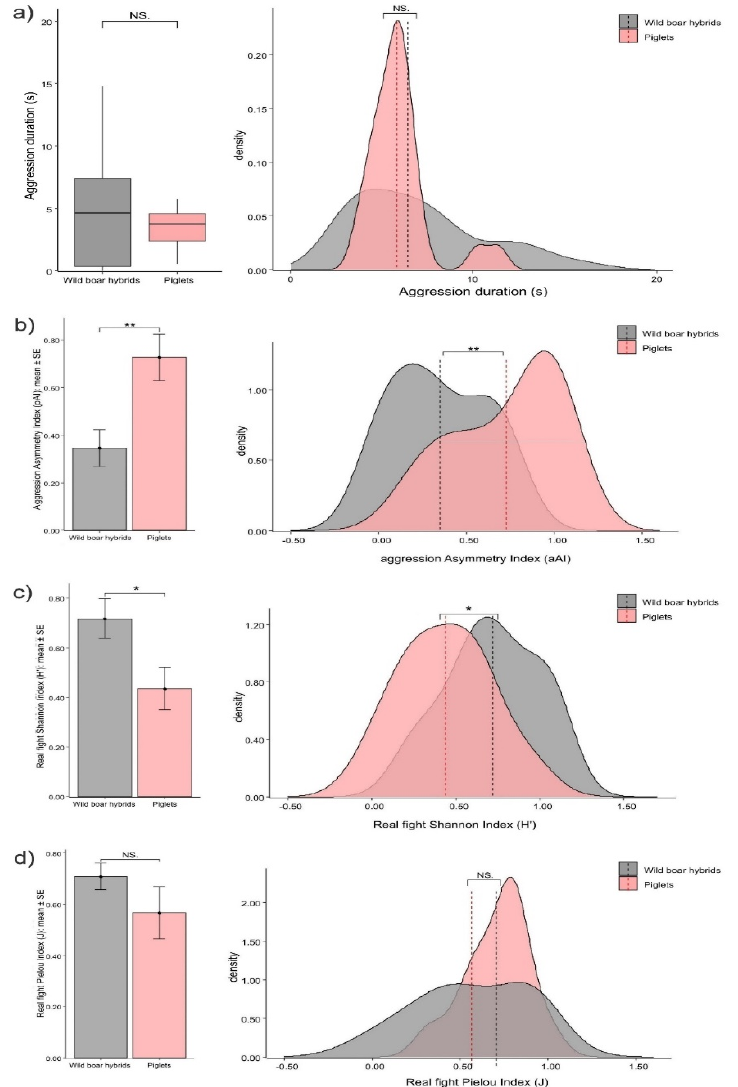
Figure 5. Differences in aggression duration between piglets and wild boar hybrids shown as bar plot (left) and density plot (right). ( a ) Piglets and wild boar hybrids show comparable levels in the